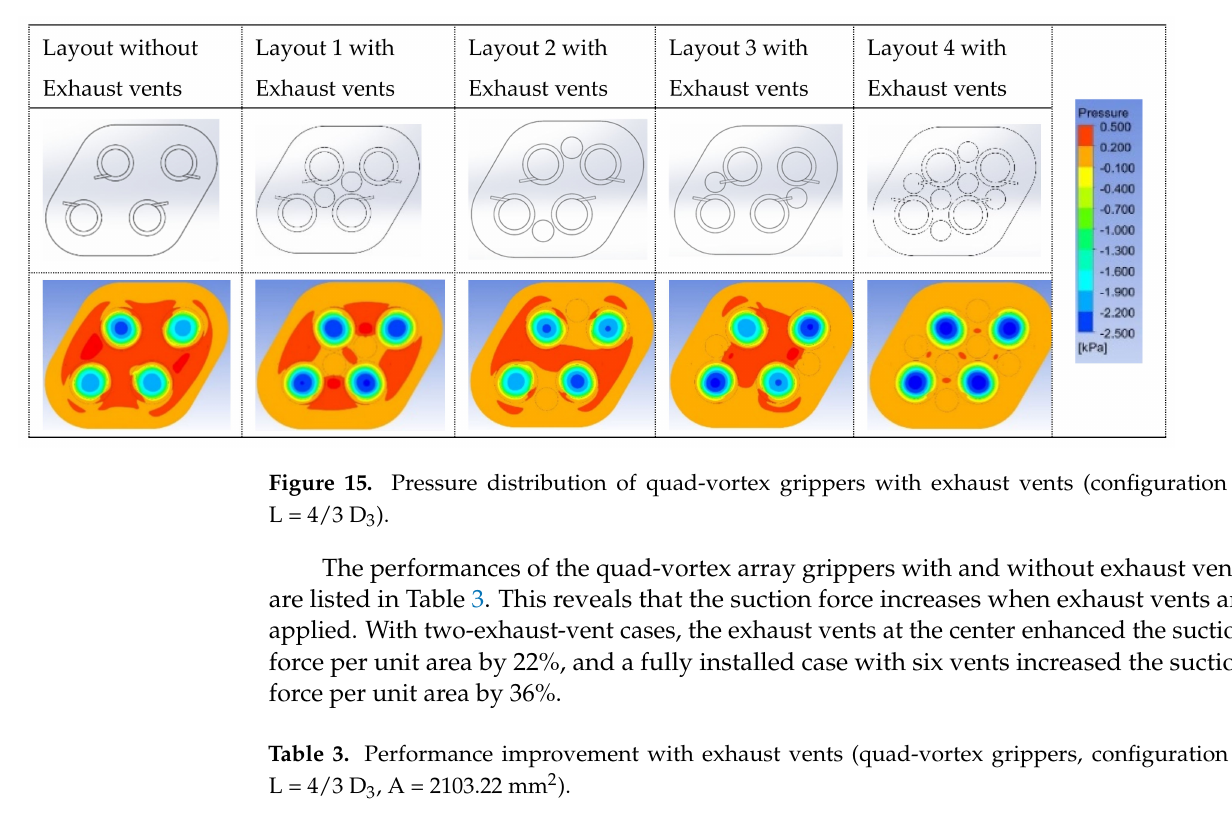
Figure 14. The structure of quad-vortex array grippers with exhaust vents.